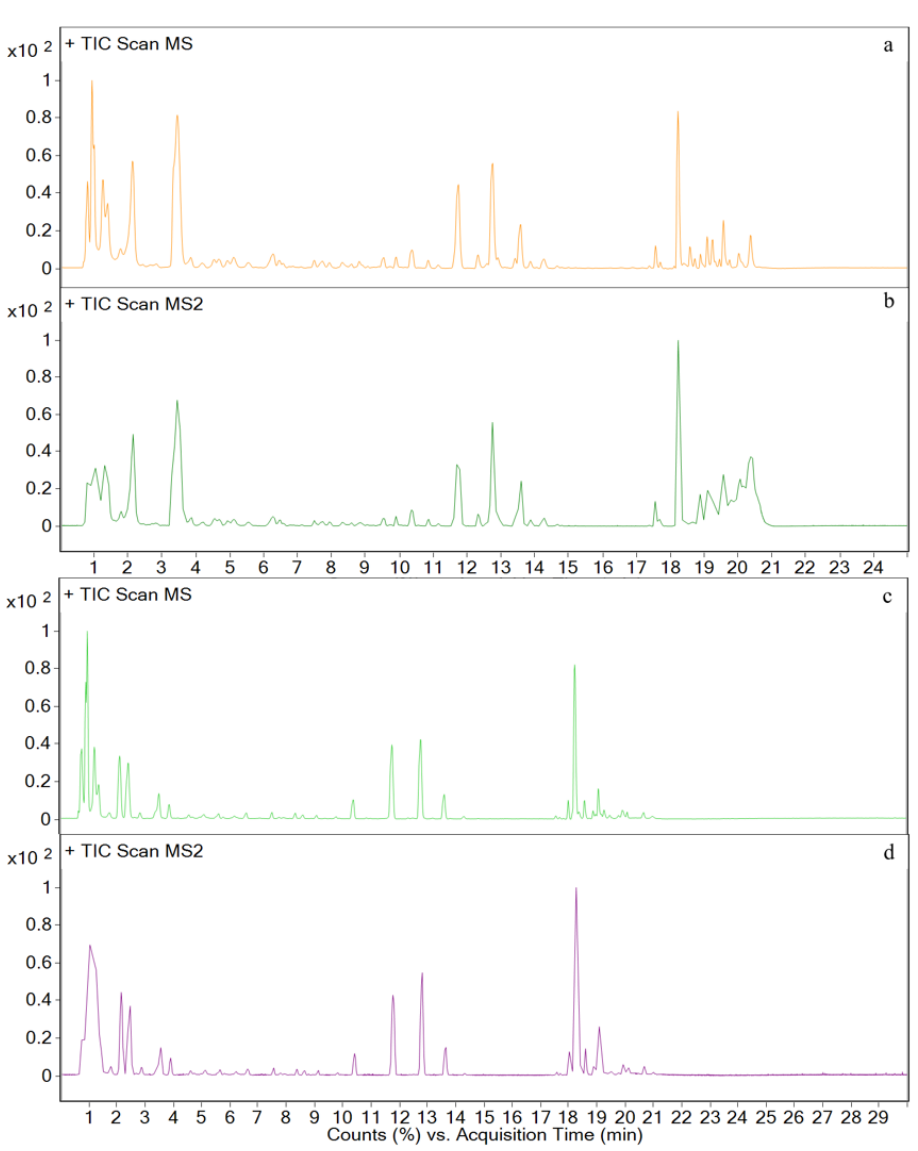
Figure A1. Total ion chromatograms of urine. ( a , b ) Blank urine; ( c , d ) Sample urine.